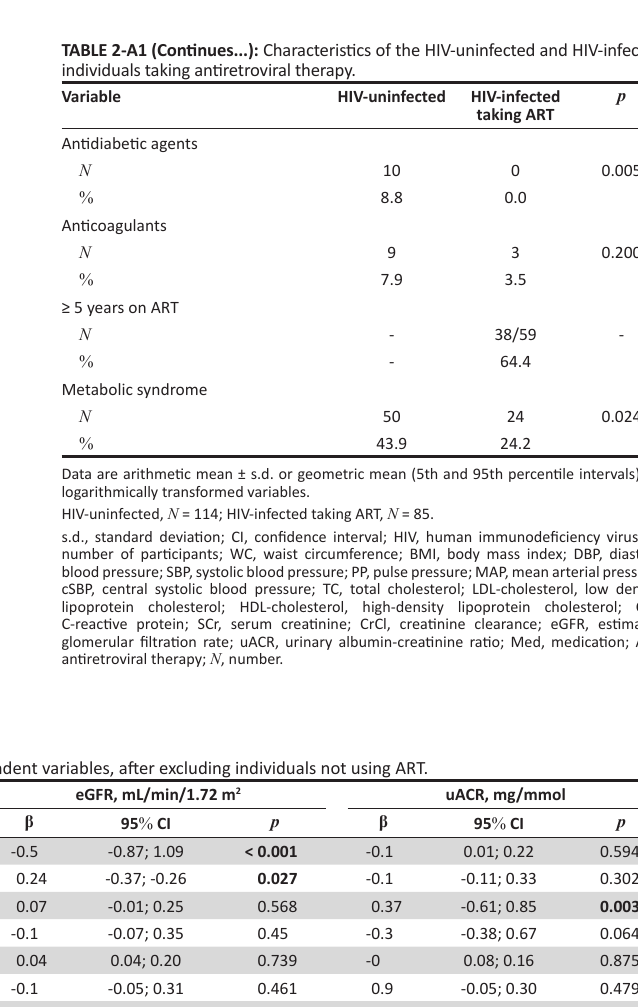
TABLE 2-A1 (Continues...): Characteristics of the HIV-uninfected and HIV-infected individuals taking antiretroviral therapy.